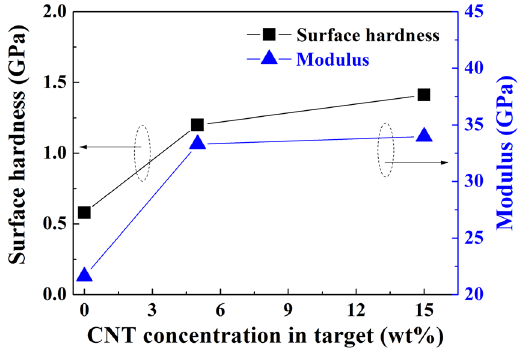
Figure 7. Surface hardness and modulus of the fluorocarbon thin film as a function of the CNT concentration in the composite